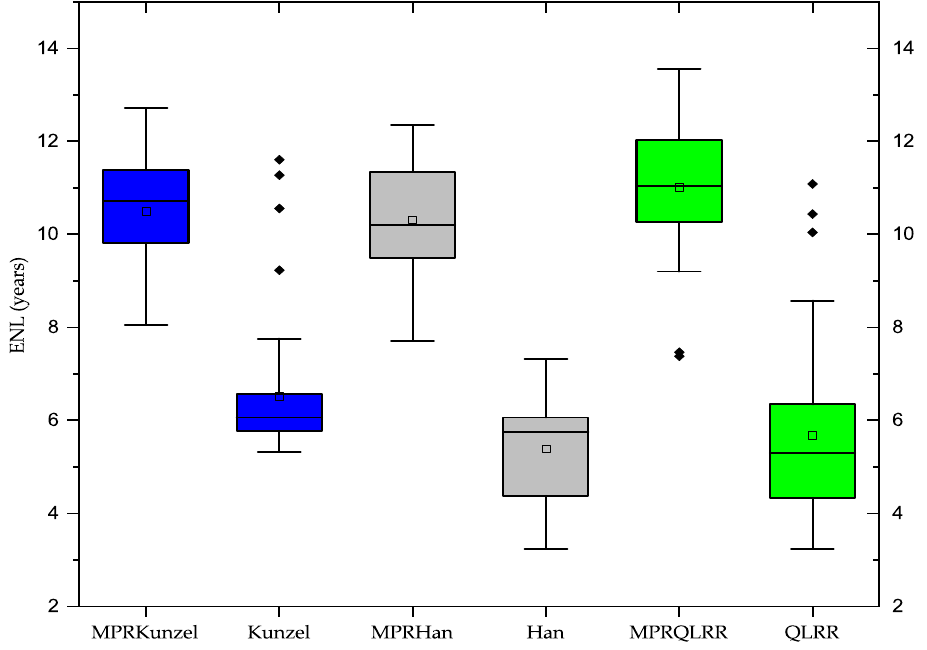
Figure 8. Expected network lifetime (ENL) performance